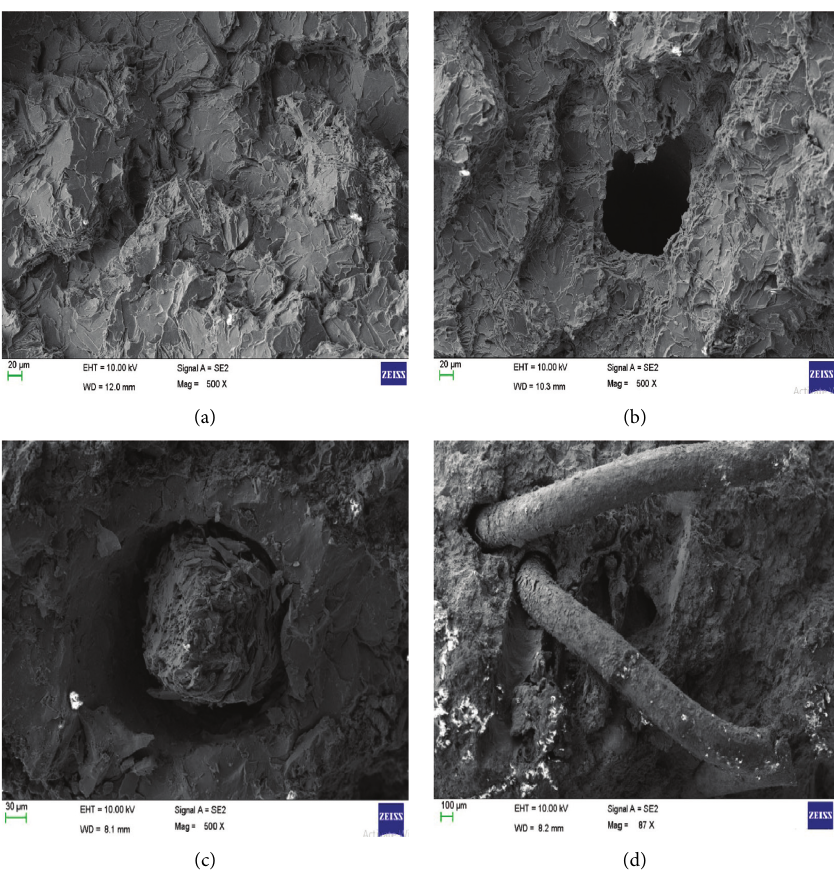
Figure 10: (a) Rupture surface of LM6 Al alloy. (b) Rupture surface with dimples of LM6 Al alloy hybrid composites. (c) LM6 Al alloy hybrid composites with broken wires. (d) LM6 Al alloy hybrid composites with two broken